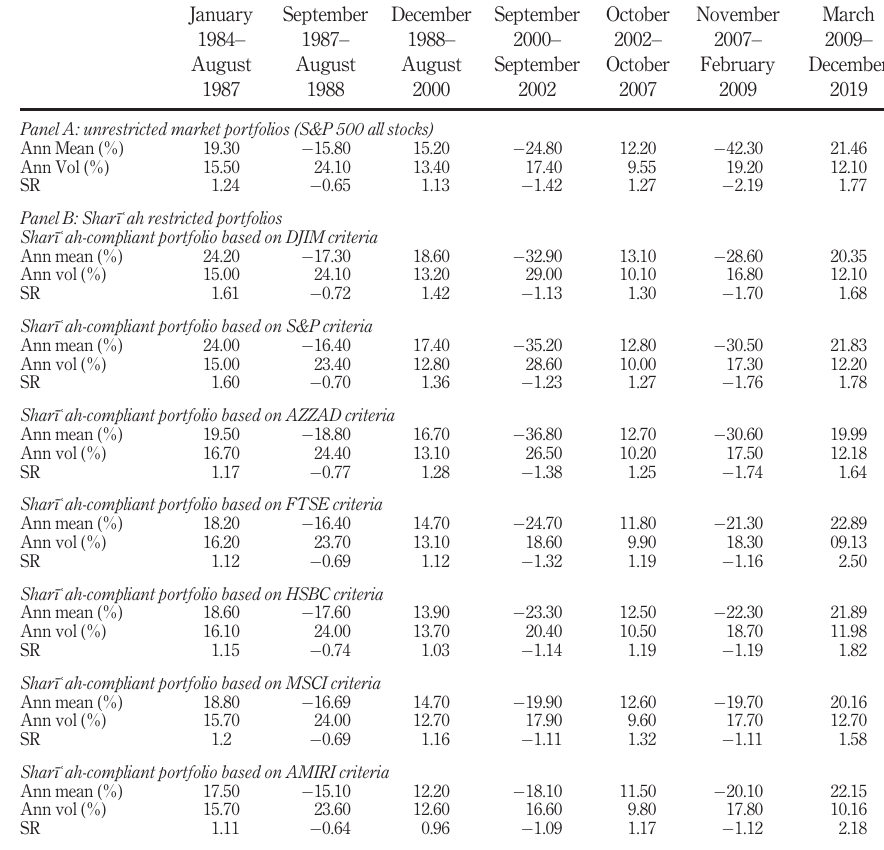
Table 5. Performance of SCEPs in different time periods